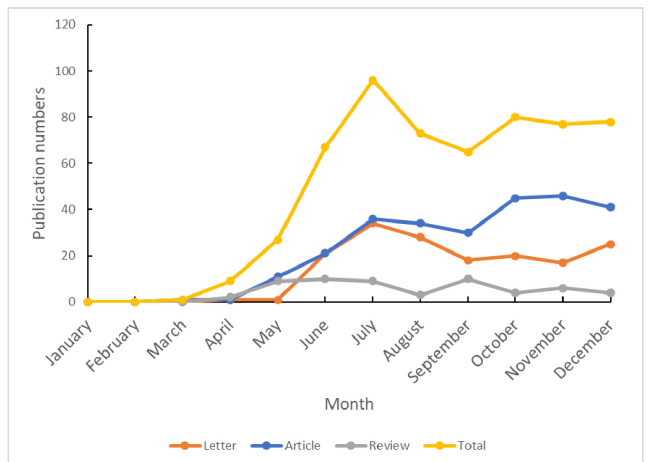
Figure 2. Monthly numbers of three major types of published research and all coronavirus disease 2019-related publications in 2020 in emergency medicine